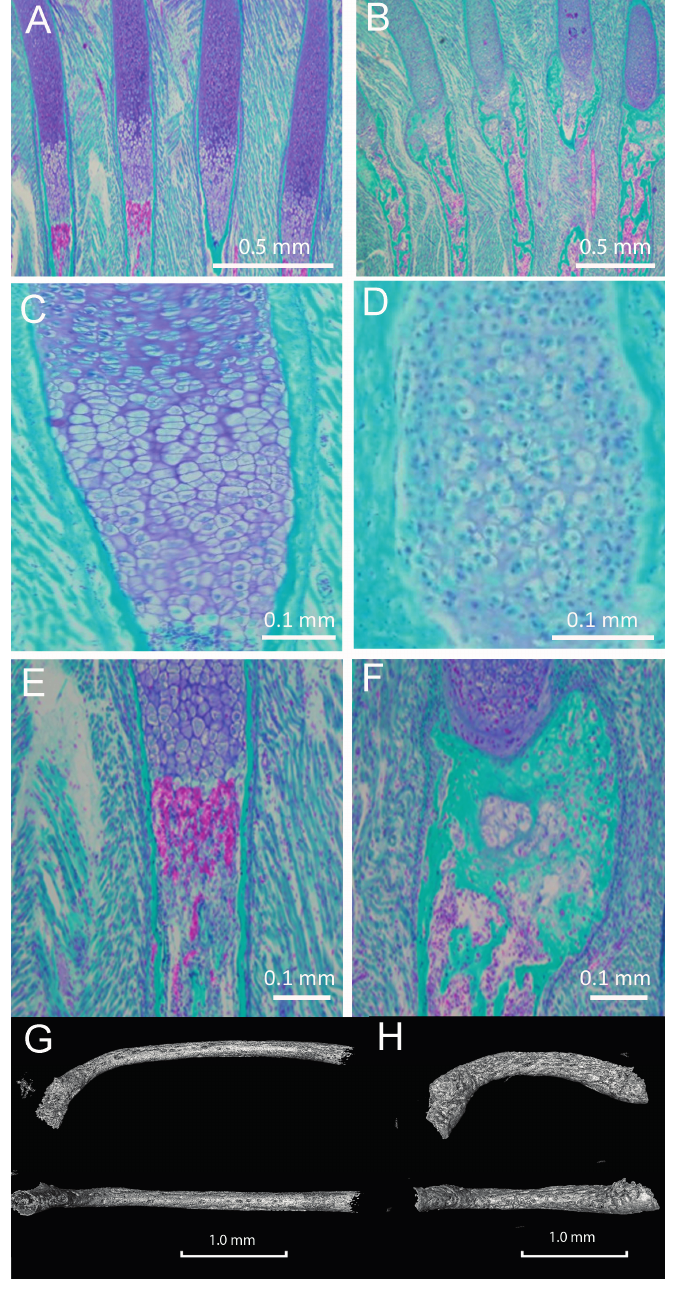
Figure 6. Comparison of ribs between WT and Col11a1-deficient mice. ( A , C , E , G ) WT ( B , D , F , H ) Col11a1-deficient mouse. ( A and B ) Histological differences in four adjacent ribs for WT and Col11a1-deficient mice. Trichrome staining rendered mineralized tissue green, cartilage tissue deep blue, and blood cells pink/purple. ( C and D ) Histological differences within proliferative/hypertrophic chondrocytes from WT and Col11a1 − / − . ( E and F ) Col11a1-deficiency led to an increase in mineralization in the newly-formed bone collar in the Col11a1-deficient mouse compared to WT. Images in C, D, E, F are from representative ribs not appearing in A and B. ( G and H ) Reduced length, increased curvature of the ribs was apparent in the Col11a1-deficient mice compared to WT. Proximal is oriented to the left for each rib, with the distal growth plate located on the right. Scale bars A and B = 0.5 mm; C and D = 0.1 mm; E and F = 1.0